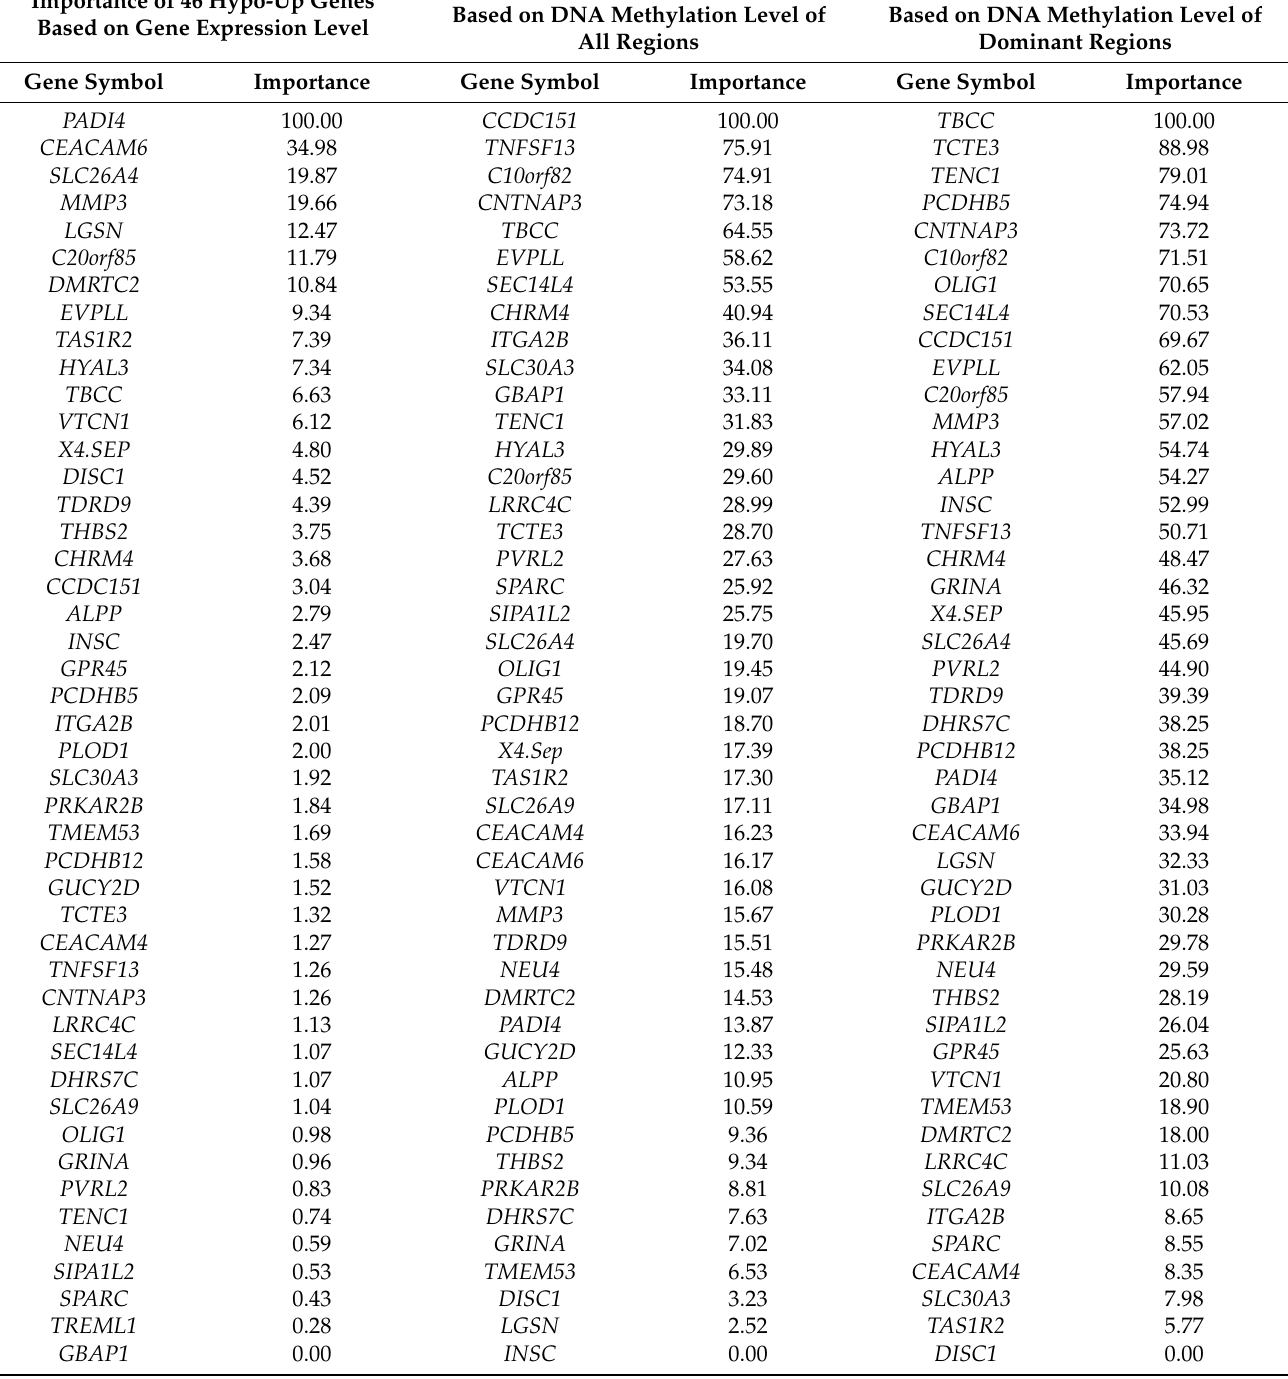
Table 3. Gene symbol and importance scores of 46 hypo-up genes in gene expression classifier and gene methylation classifiers. Importance of 46 Hypo-Up